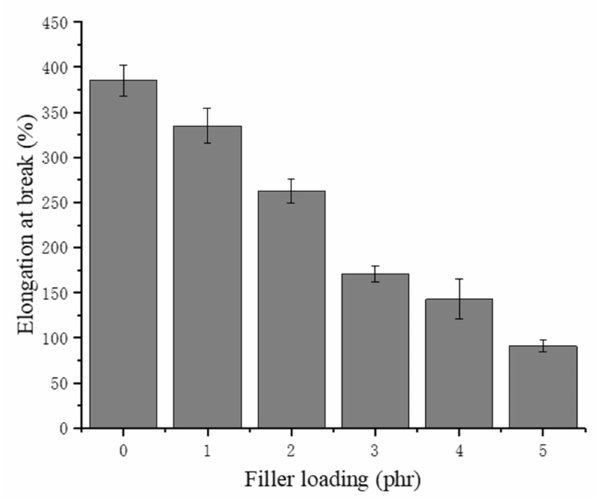
Figure 9. Elongation at break of chitin–NRLF.